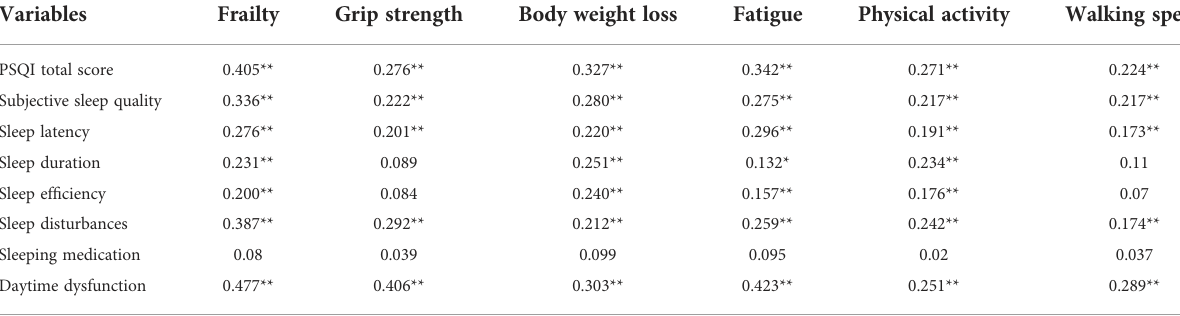
TABLE 6 Correlation analysis among frailty and sleep quality (N =